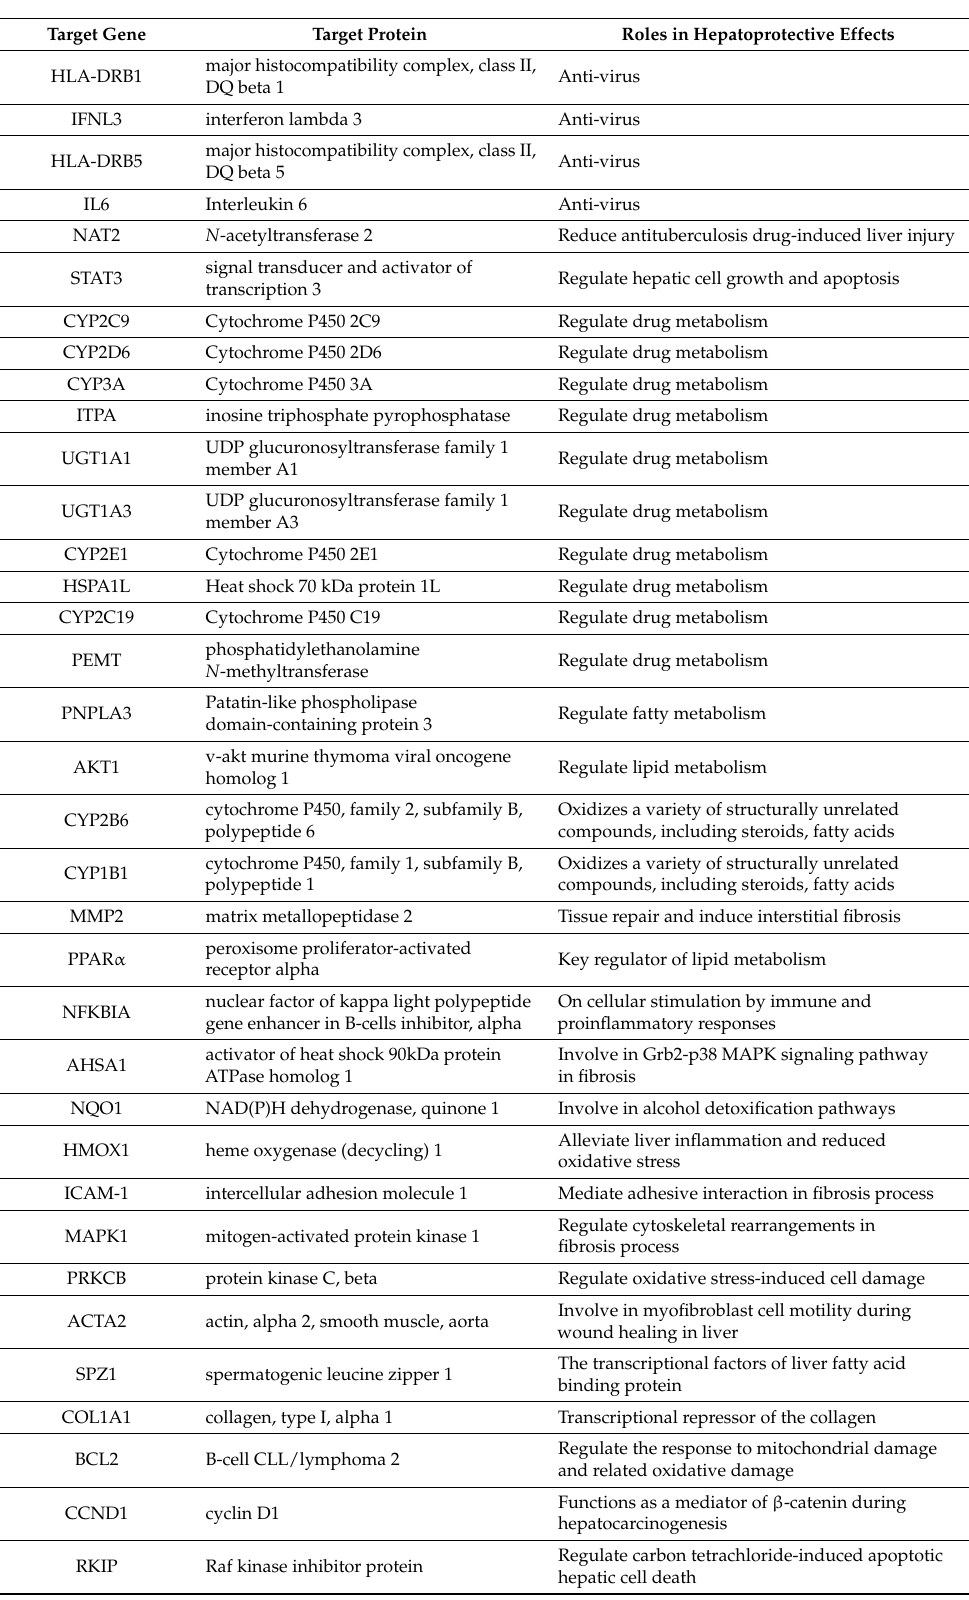
Table 1. Forty-four protein targets related with viral hepatitis, fatty liver, liver fibrosis, cirrhosis, and liver